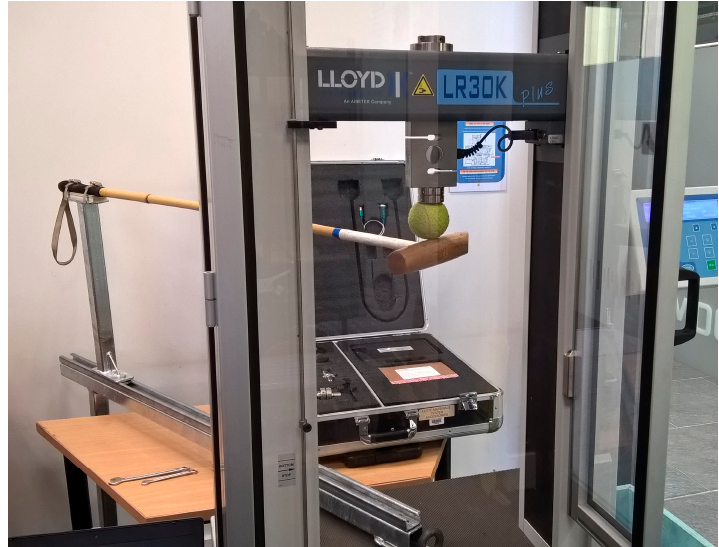
Figure 4. The testing kit with the stick mounted to undertake direct loading in the vertical plane.